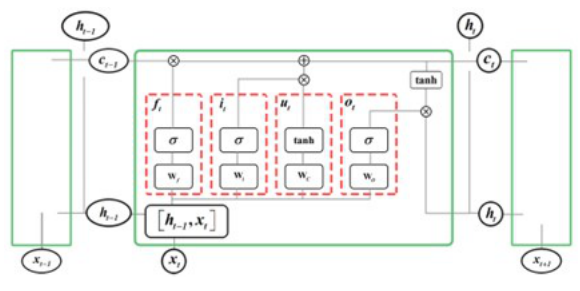
Fig. 1. The structure of LSTM